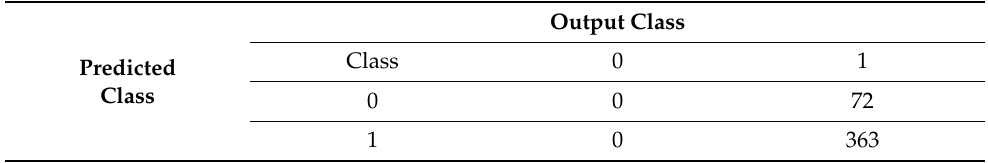
Table 3. Confusion matrix for machining